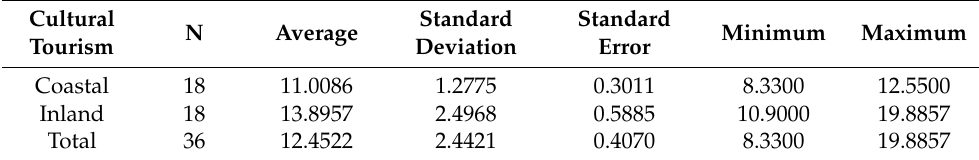
Table 2. Descriptive statistics of the coastal and inland ACs.